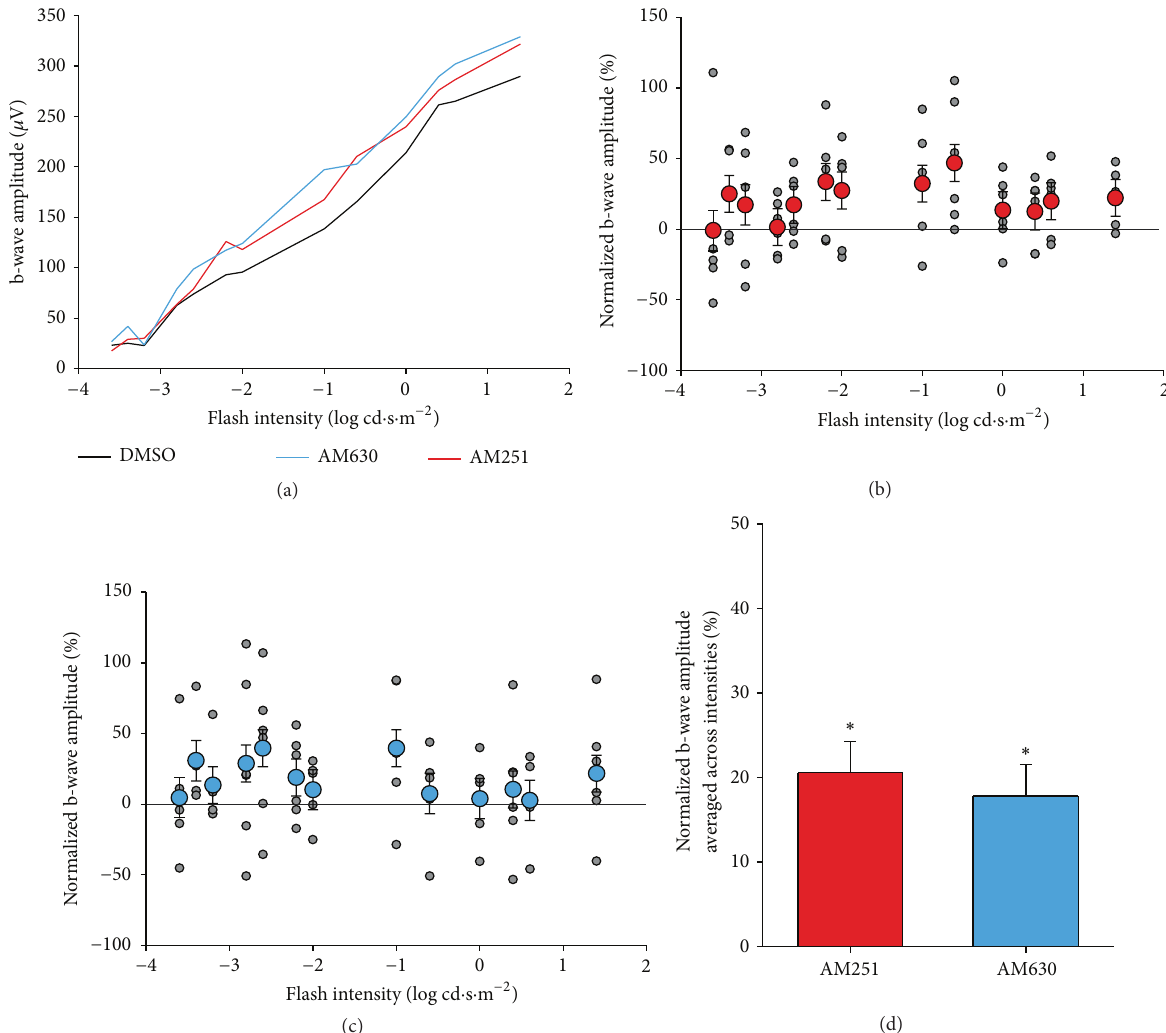
Figure 6: Scotopic b-wave amplitudes. (a) Amplitudes of scotopic ERG b-waves plotted as a function of flash intensities. (b) Scatter plot for normalized b-wave amplitude as a function of flash intensity in AM251-injected monkeys. Grey points indicate raw values; red data points with error bars indicate the mean and standard error of the mean. (c) Scatter plot and linear regression for normalized b-wave amplitude as a function of flash intensity in AM630-injected monkeys. Grey points indicate raw values; blue data points with error bars indicate the mean and standard error of the mean. (d) Main effect of average amplitudes across intensities in AM251 (red) or AM630 (blue) groups. ∗ 𝑝 < .05 .